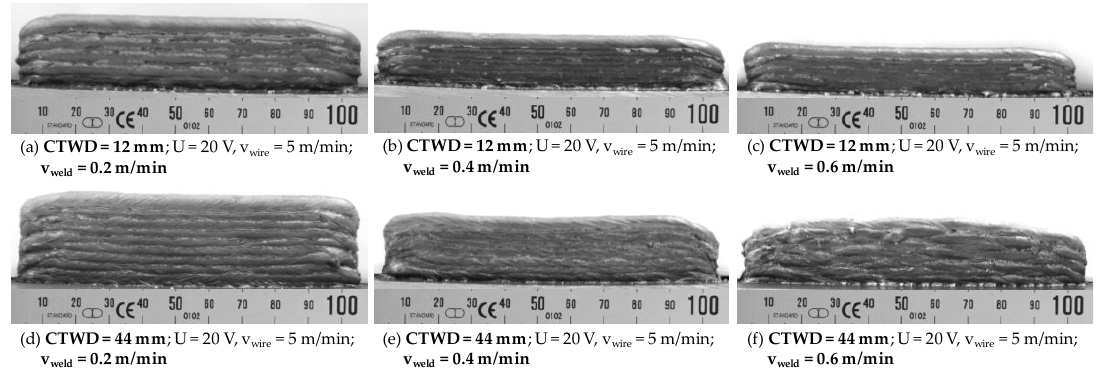
Figure 9. Correlation of CTWD adjustment and differing welding speeds on wetting behavior and near net shape quality during WAAM.